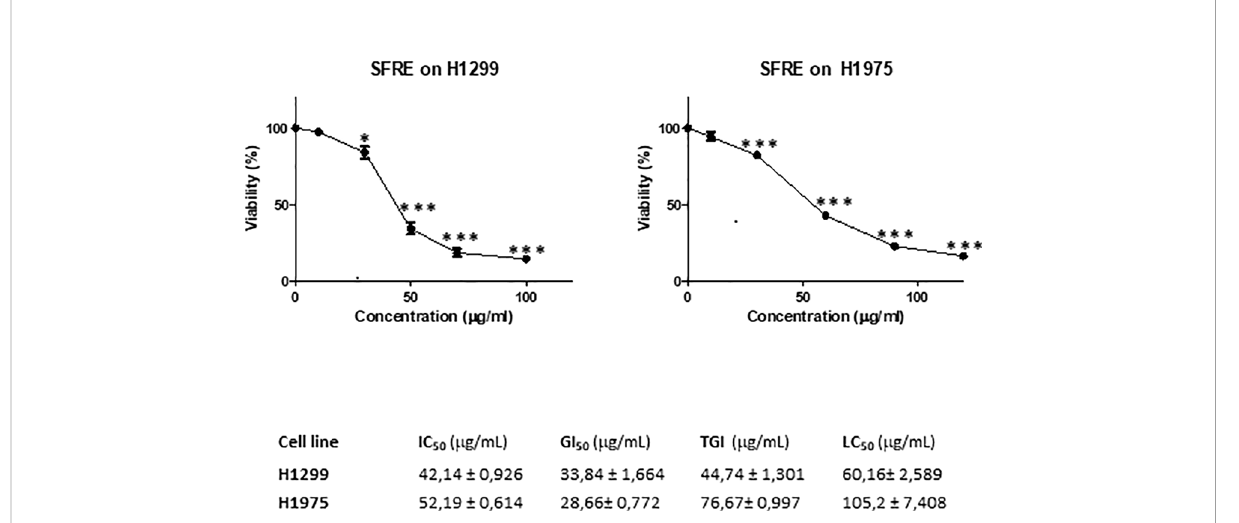
FIGURE 1 SFRE inhibits cell proliferation of NSCLC cell lines -H1299 and H1975. Dose – response curves of the cell proliferation assay after 48 h of treatment with increasing concentrations of SFRE. Data represent mean ± SEM of three independent experiments, each performed in triplicates. Values corresponding to IC 50 , GI 50 , TGI and LC 50 after 48 h of SFRE treatment are indicated. Results are shown as the mean ± SEM of three independent experiments, with 4 replicates/experiment. Asterisks * and *** indicate p values < 0.05 and 0.005,